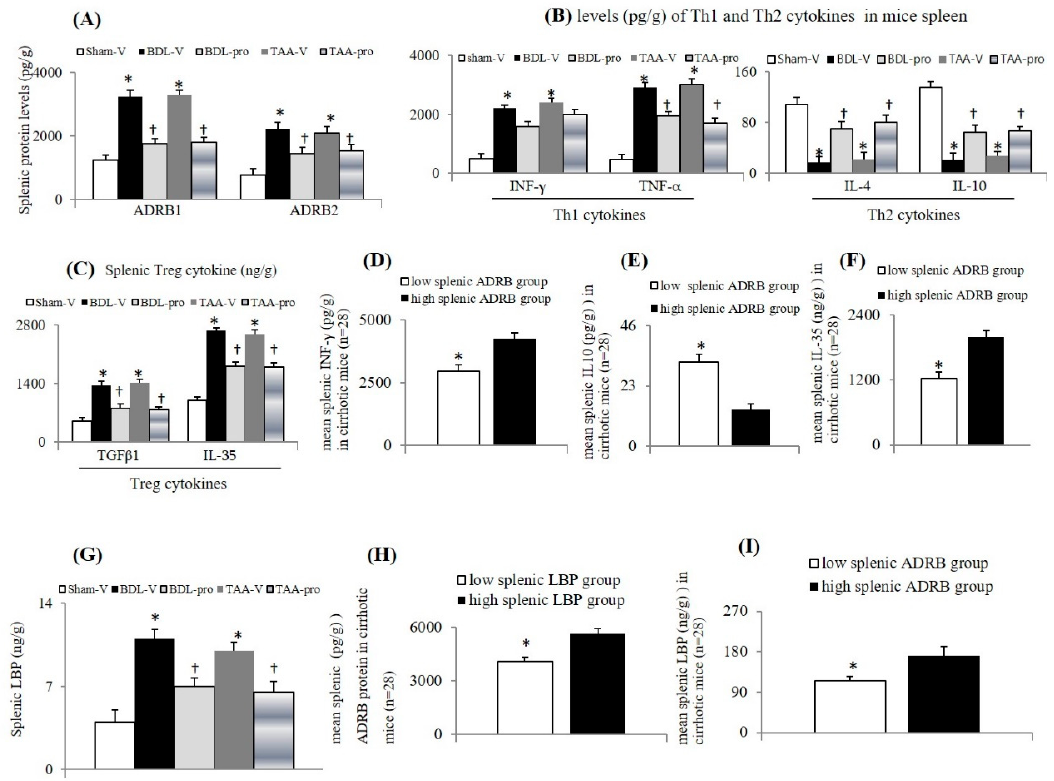
Figure 5. High tissue levels of ADRB1/ADRB2 proteins were associated with high levels of Th1/Treg cytokines and LBP in the spleens of cirrhotic mice. ( A – C ) levels of ADRB1/ADRB2 proteins and of Th1/Th2/Treg cytokines; ( D – F ) Mean levels of INF- γ , IL-10 and IL-35 in cirrhotic mice of “high” ADRB and “low” ADRB groups. ( G ) Splenic LBP level between groups; ( H ) LBP levels in cirrhotic mice of “high” ADRB group and “low” ADRB group. ( I ) ADRB protein Levels between “high LBP” and “low LBP” groups. In cirrhotic mice, “high” ADRB or LBP groups were defined by high percentages (> third percentile, cut-off point is 393 for ADRB protein levels, and 1057 for splenic LBP levels) of summative increased splenic ADRB1 and ADRB2 protein or LBP levels compared to sham-V mice. * p < 0.05 vs. sham-V/high ADRB or LBP groups; † p < 0.05 vs. BDL-V/TAA-V group; LBP: lipopolysaccharide binding protein.